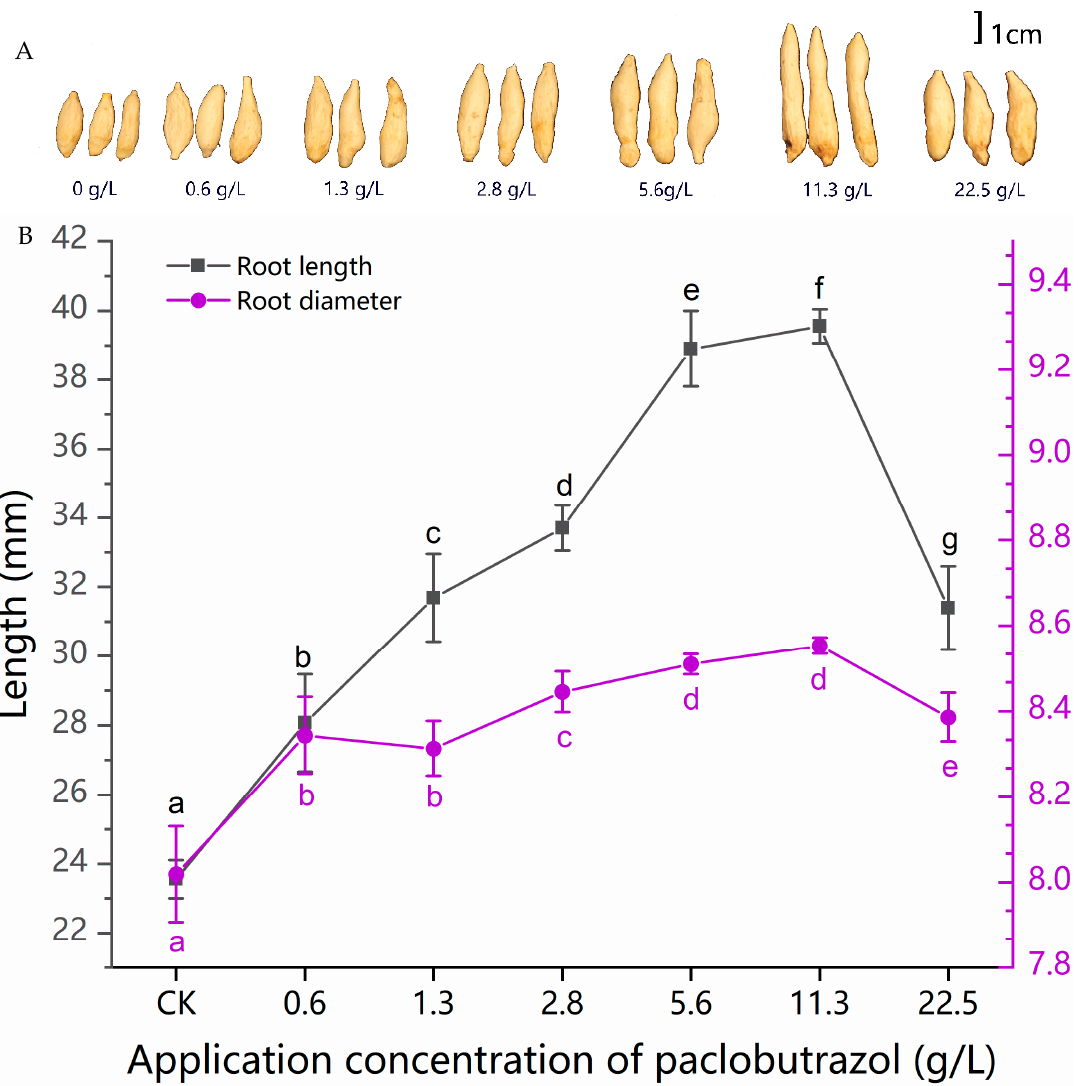
Figure 4. Overall comparison of Ophiopogon roots after application of paclobutrazol at different concentrations: ( A ) root diameter and root length ( B ). Different letters (a, b, c, d, e, f and g) represent significant differences ( p ≤ 0.01) across treatments according to Tukey’s SD test. Vertical bars represent standard errors.